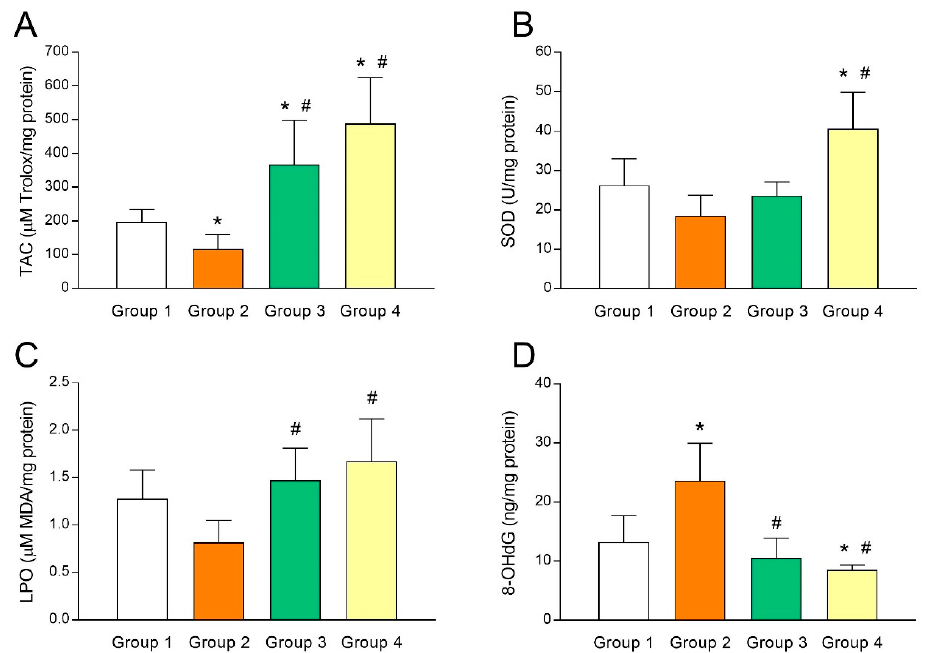
Figure 2. Altered intrafollicular oxidative balance in patients with unexplained infertility is countered by melatonin administration. ( A ) Total antioxidant capacity (TAC), ( B ) superoxide dismutase (SOD) activity, ( C ) lipid peroxidation (LPO), and ( D ) 8-hydroxy-2’-deoxyguanosine (8-OHdG) concentrations in the follicular fluids of fertile women (group 1) and UI patients untreated (group 2) or treated with 3 mg/day (group 3) or 6 mg/day (group 4) of melatonin. Values represent means ± SD of 10 individuals. * p < 0.05 vs. group 1. # p < 0.05 vs. group 2.